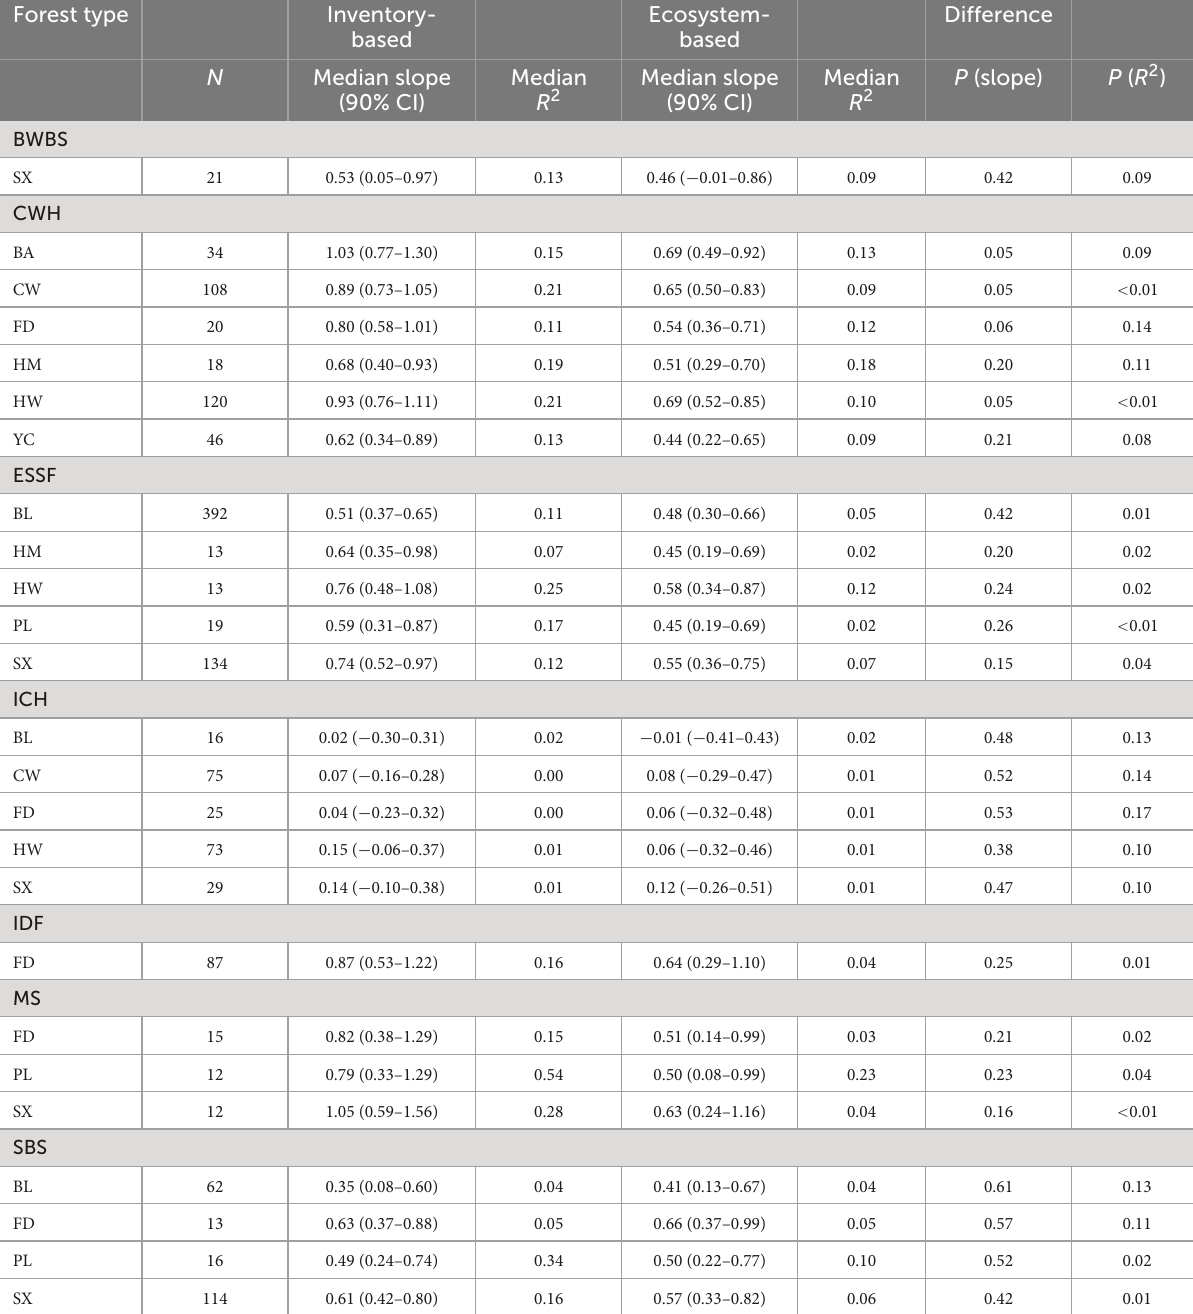
TABLE 1 Relationship between site index and measured tree height by forest type (predominant species within the biogeoclimatic zone; groups with N > 10 ground plots). Forest